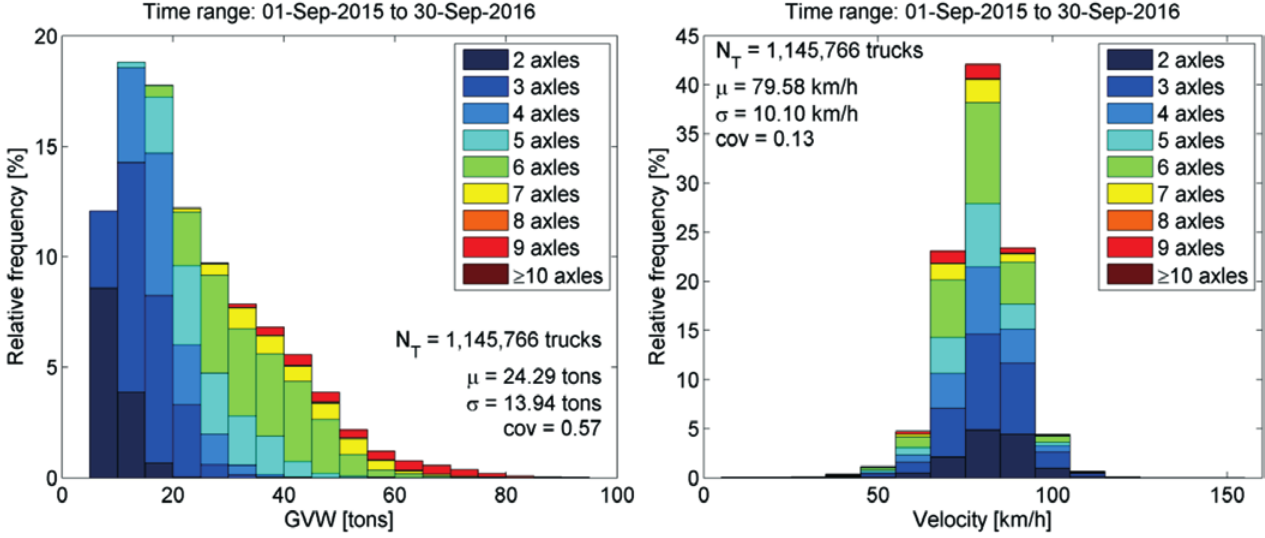
GVW and speed statistics for different trucks clusters base on axle number